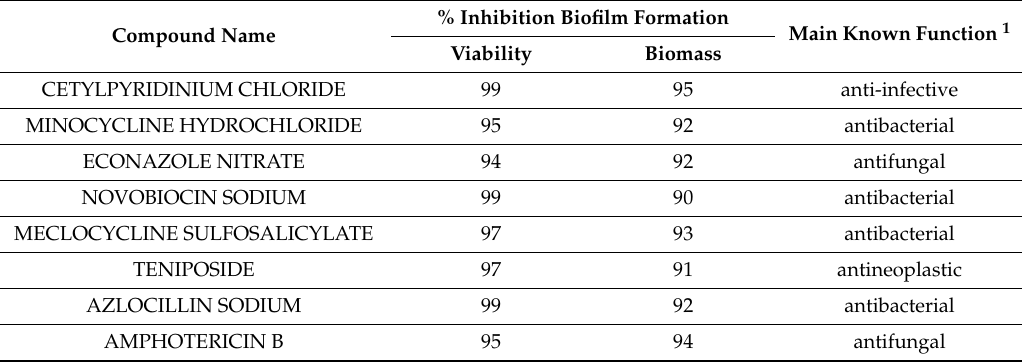
Table A1. Hits preventing over 80% of S. aureus biofilm formation from the screening of 2000 compounds from the Microsource Spectrum Collection (Discovery Systems